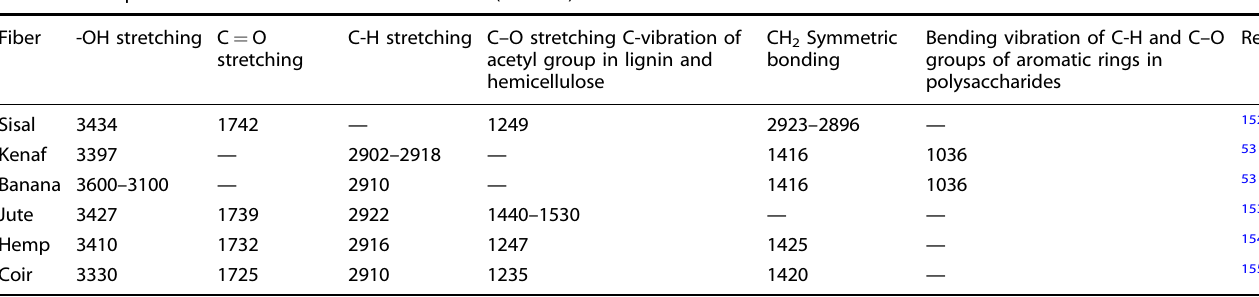
Table 6. FTIR peaks of different untreated natural fi bers (in cm − 1